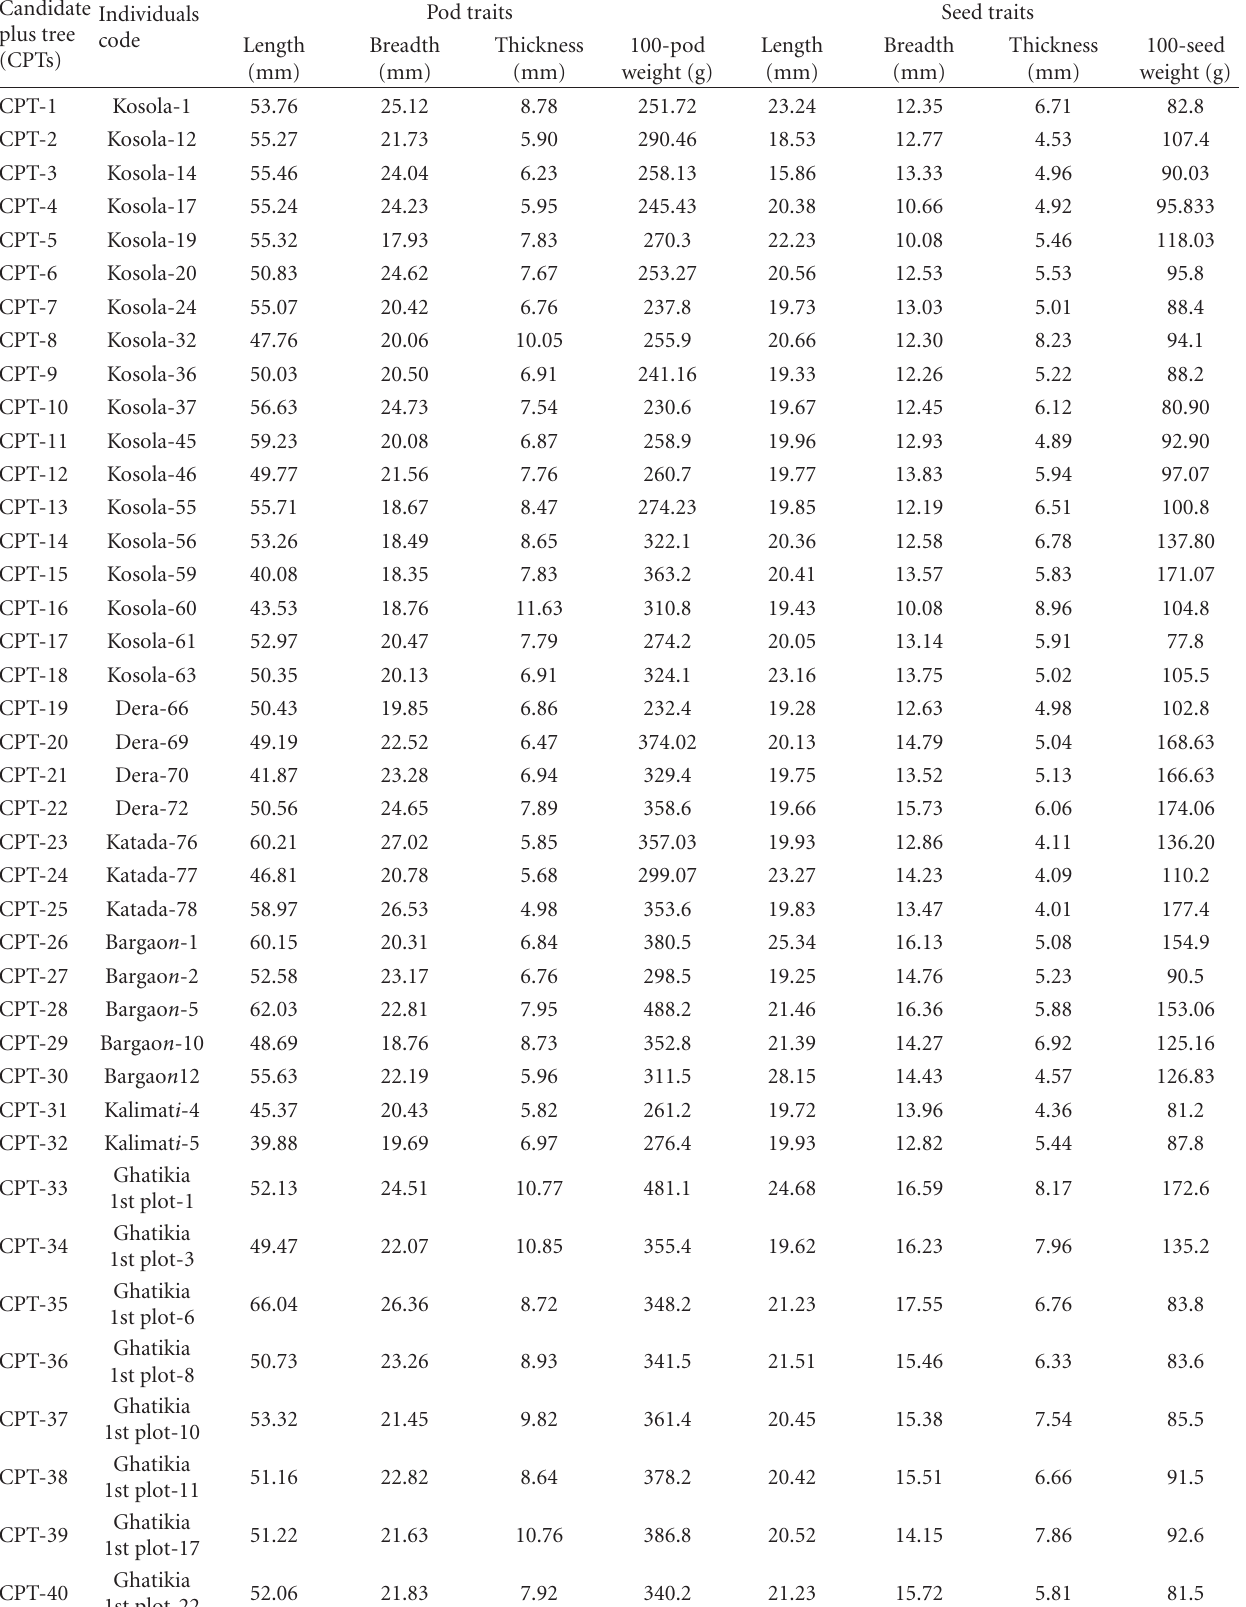
Table 2: Mean performance of CPTs (candidate plus trees) variation for pod and seed trait in Pongamia pinnata